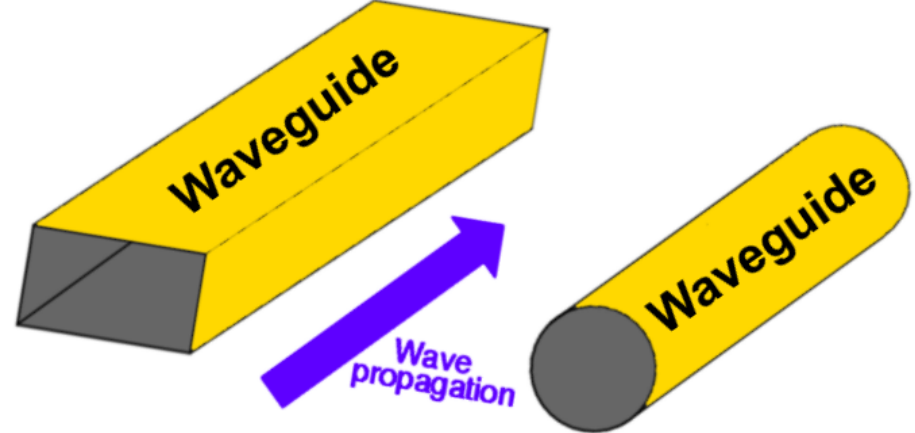
Figure 12. Rectangular and circular waveguides.